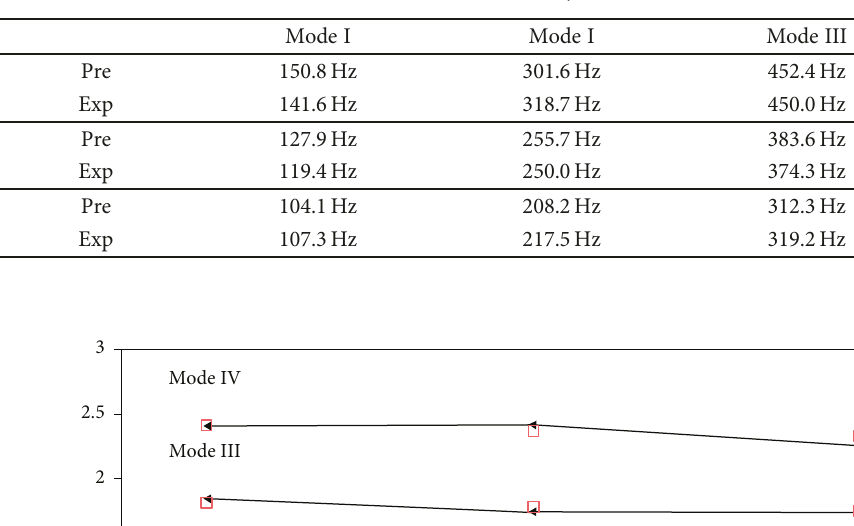
Table 2: Modes of the cavity